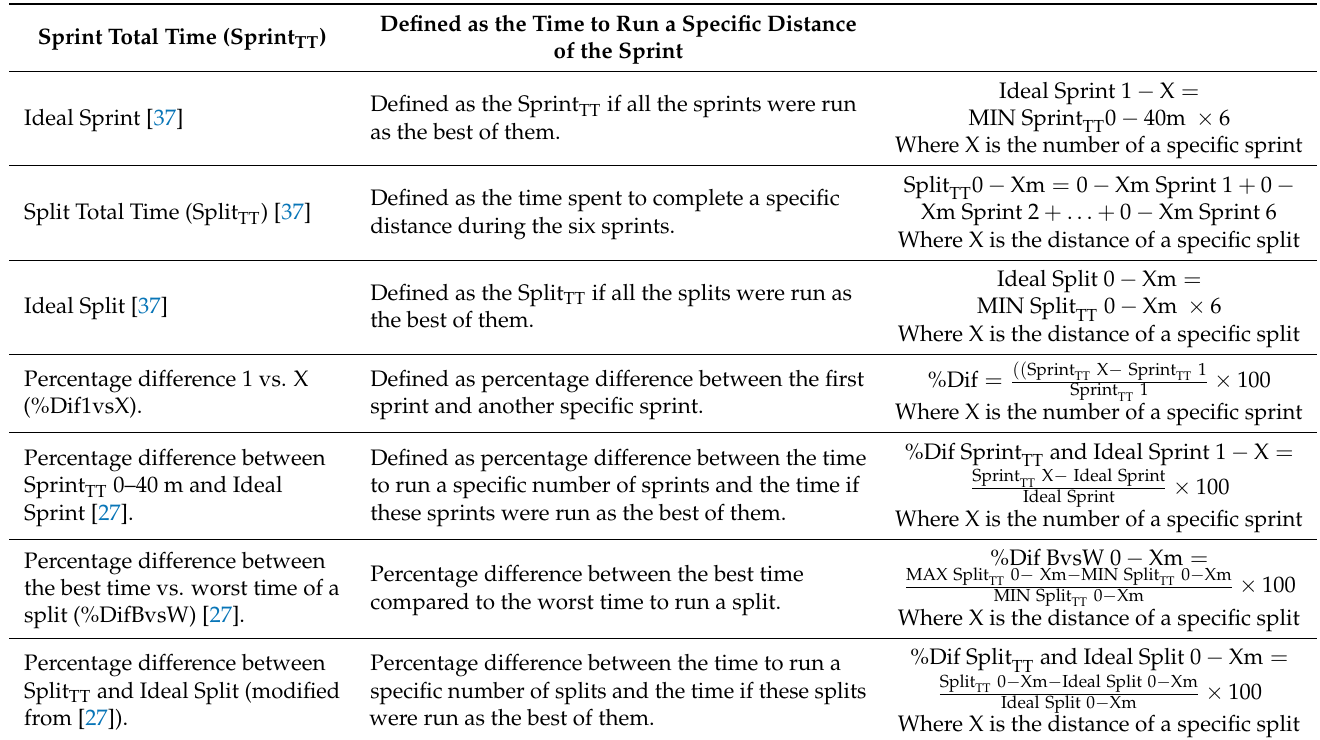
Table 1. Calculations of the different variables to evaluate fatigue during the RSA